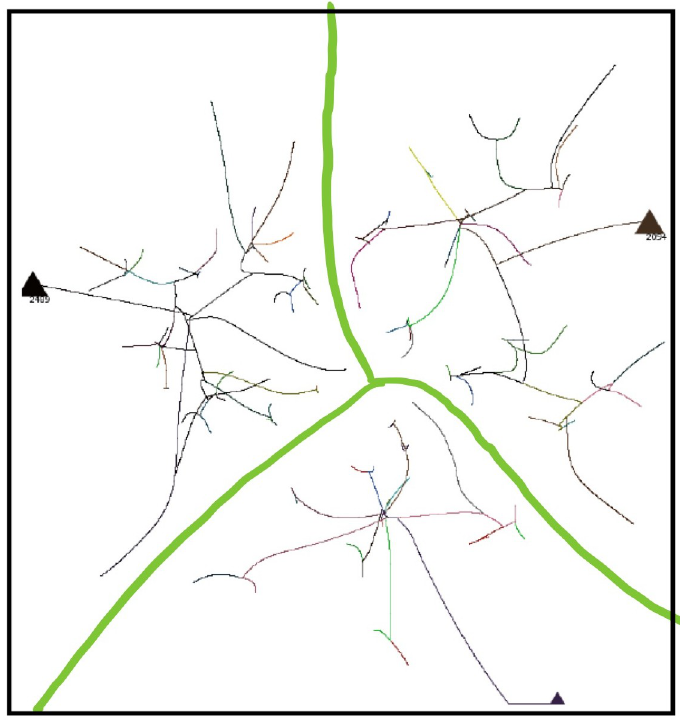
Fig 22. Attribute sheds present in a simulation with AIB = 200, shown with thick solid lines. Agent trails show that no agents have crossed these dividing lines during the simulation.